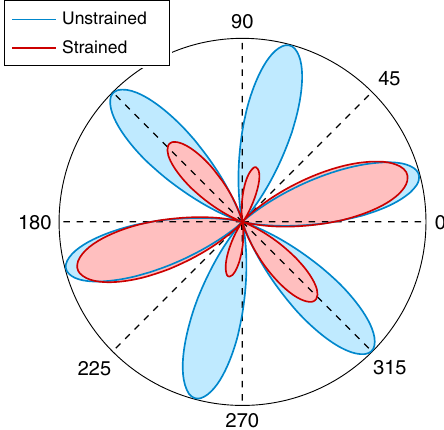
Fig. 2 Polarization resolved SHG intensity I 2 ð Þ jj 2 ω ð Þ pattern. The plot shows the component of the SHG signal with same polarization as the incident fi eld. Blue line: unstrained TMD crystal; red line: with 1.0% tensile strain in horizontal (0°) direction ( θ =